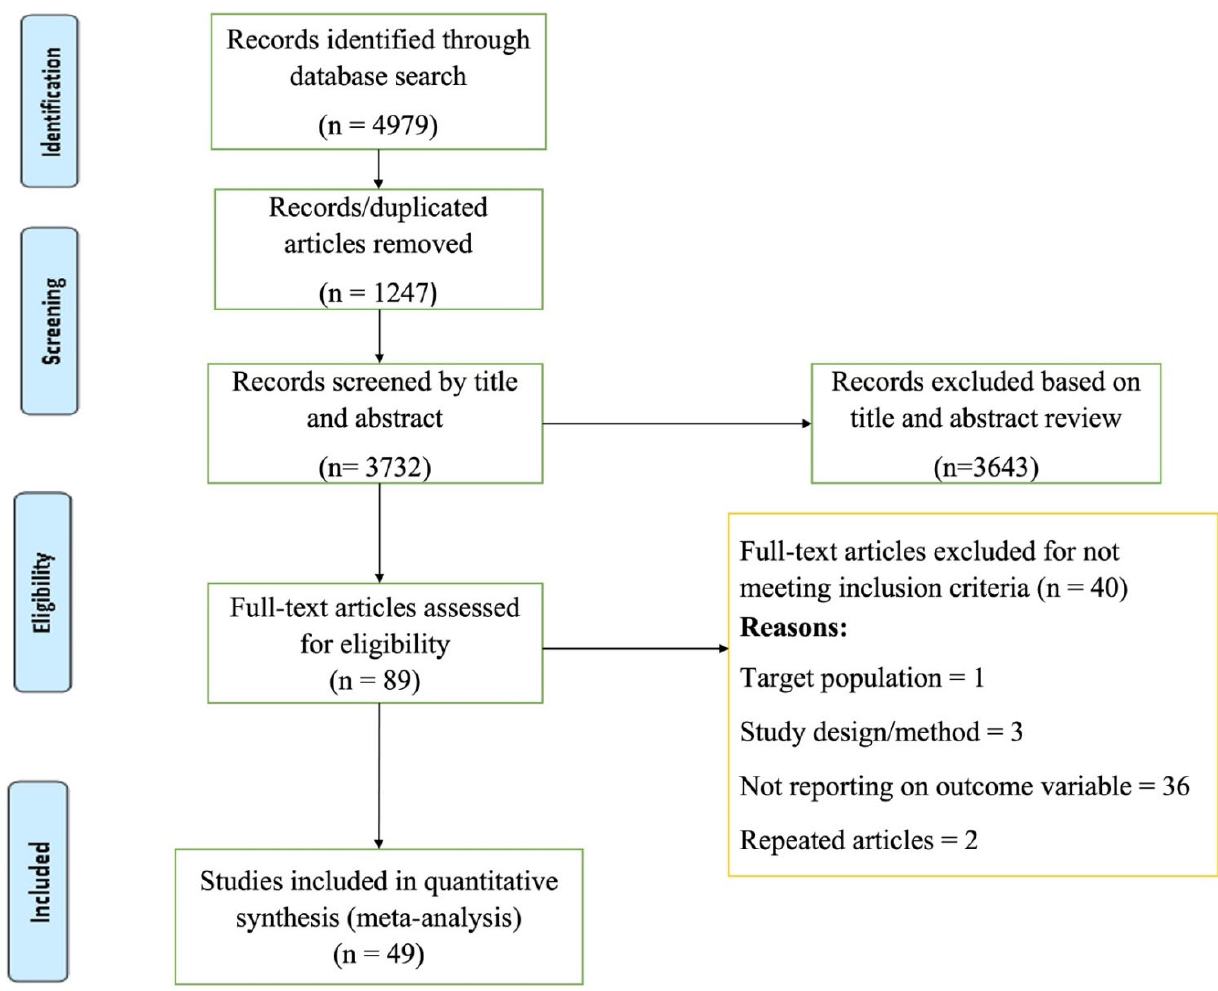
Figure 1. PRISMA flow of studies .